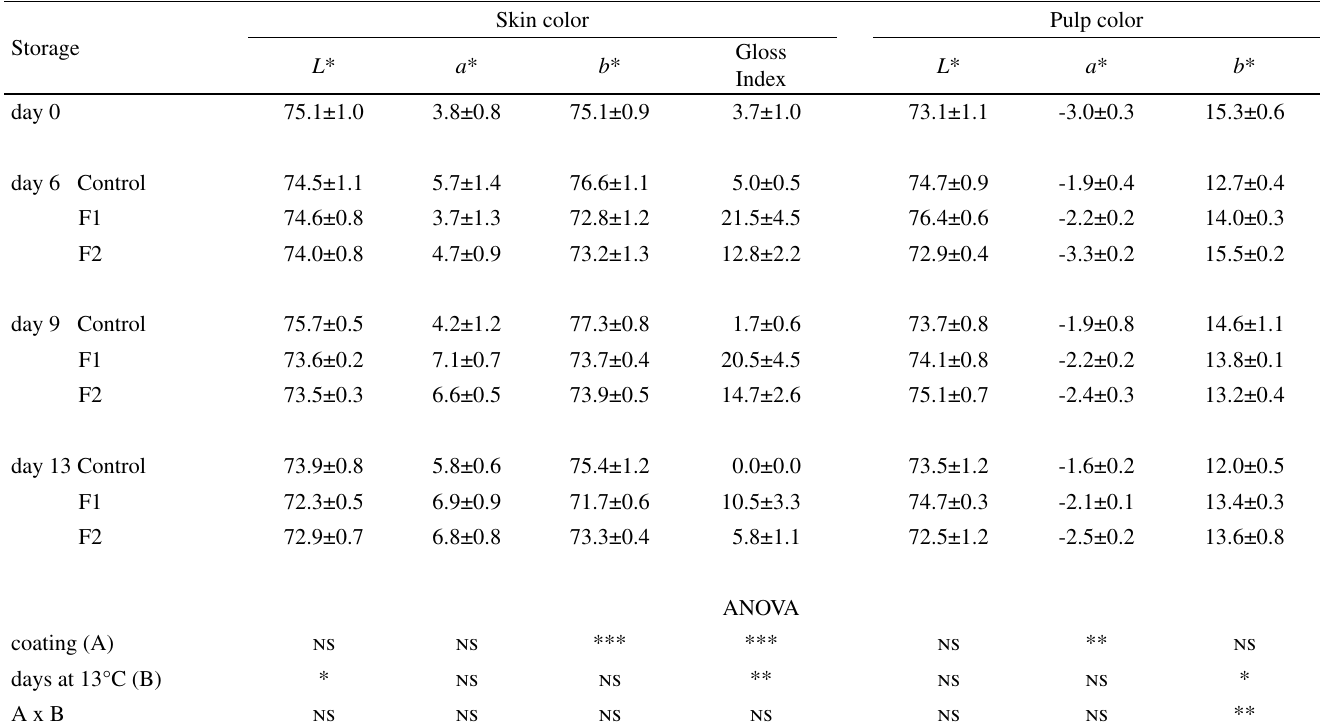
Table 1 - Skin and pulp color (mean ± standard error; n=6) of control and coated (F1, F2) melon fruit during storage at 13°C and ANOVA results